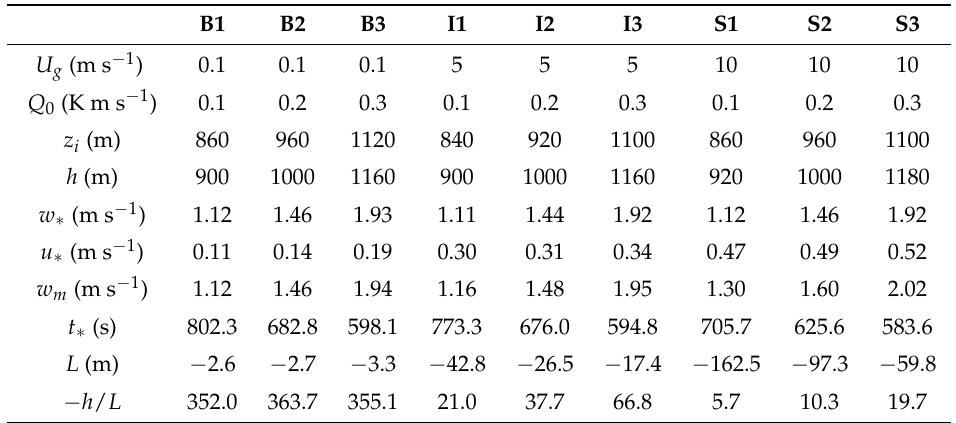
Table 1. The x -direction geostrophic wind ( U g ) , surface sensible heat flux ( Q 0 ) , boundary layer heights determined by minimum heat flux ( z i ) and maximum potential temperature gradient ( h )